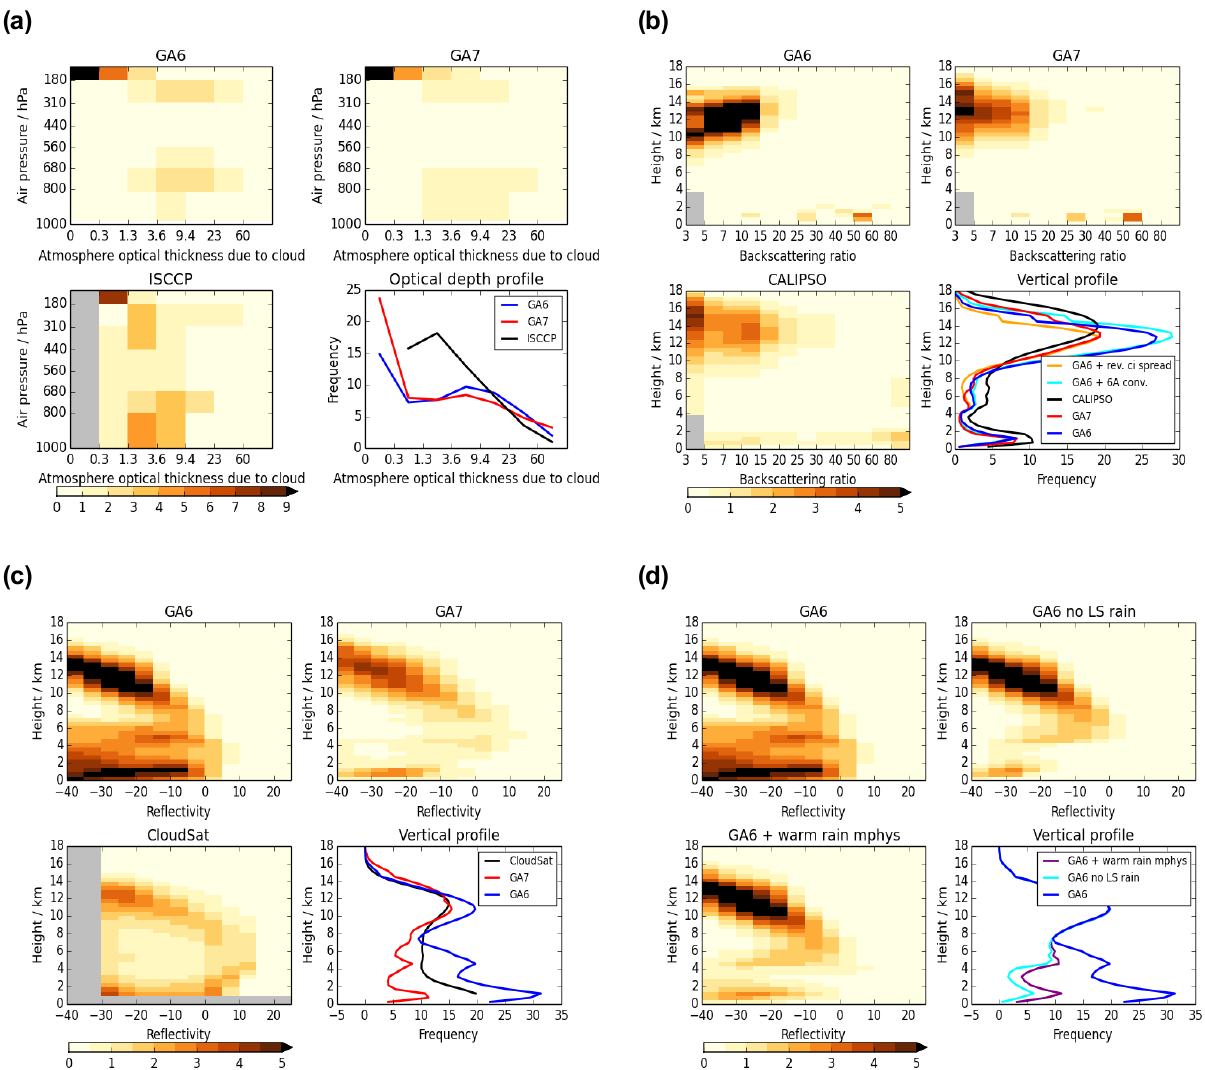
Figure 2. Tropical multi-annual mean observed and GA6- and GA7-simulated satellite data summaries. (a) ISCCP cloud-top pressure–optical depth joint frequency histograms. Lower right panel is a single optical depth frequency histogram (i.e. the joint histograms have been summed across cloud-top pressure bins). The threshold optical depth for detection by ISCCP is believed to be approximately 0.3, hence the masking of the lowest bin in the observed histogram. (b) CALIPSO backscattering ratio–frequency histograms by height. Lower right panel is a single height–frequency histogram (i.e. the backscattering ratio histograms have been summed across backscattering ratio bins in each height bin). Within the boundary layer, backscattering ratios < 5 are likely to be due to aerosols (see Fig. S1) and hence are masked. The lower right panel also shows frequency profiles for GA6 with the cirrus spreading reduced to GA7 values, and GA6 but with the 6A convection scheme used. (c) CloudSat radar reflectivity (dBZ) and frequency histograms by height. Lower right panel is a single height–frequency histogram (i.e. the reflectivity histograms have been summed across reflectivity bins in each height bin). (d) As in (c) but showing GA6, GA6 without large-scale rain being passed to the simulator, and showing GA6 plus the warm rain microphysics package which is included in GA7. Colour scale for the histograms show frequency of occurrence of cloud or hydrometeor in the bin (%). Shading around the line plots has been added to reflect significance bounds; however, this is often less than the thickness of the plotted